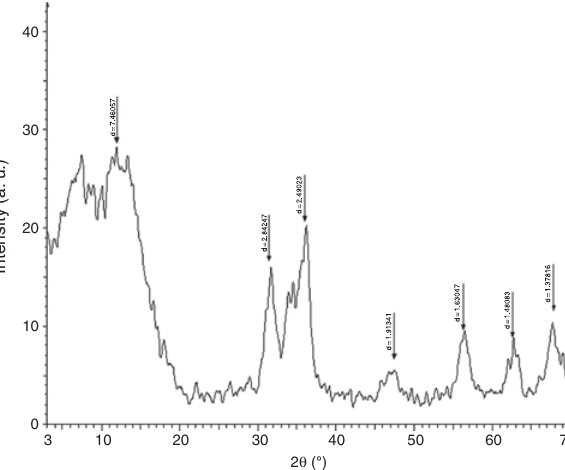
Figure 4: Response surface (A) and contour plots (B) for the antioxi- dant assay of produced ZnO NPs solution as a function of significant (p < 0.05) interaction effects of reaction time and amount of extract.